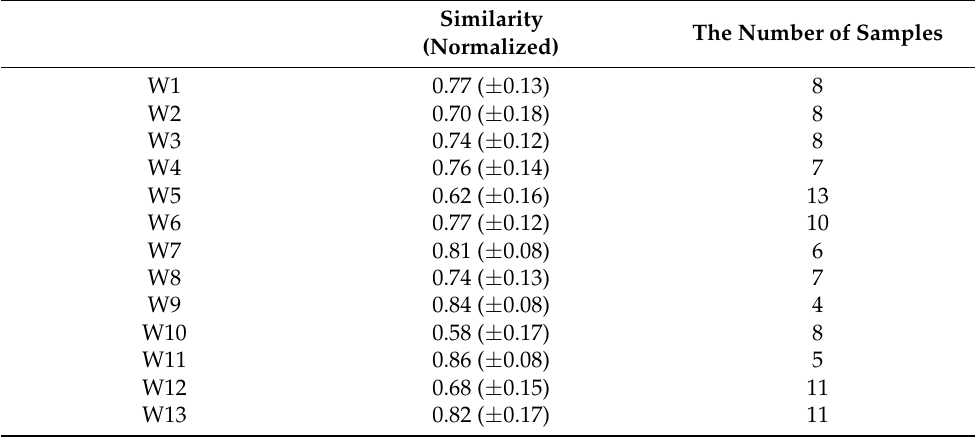
Table 2. The results for the degree of similarity within each synergy cluster of all tasks.